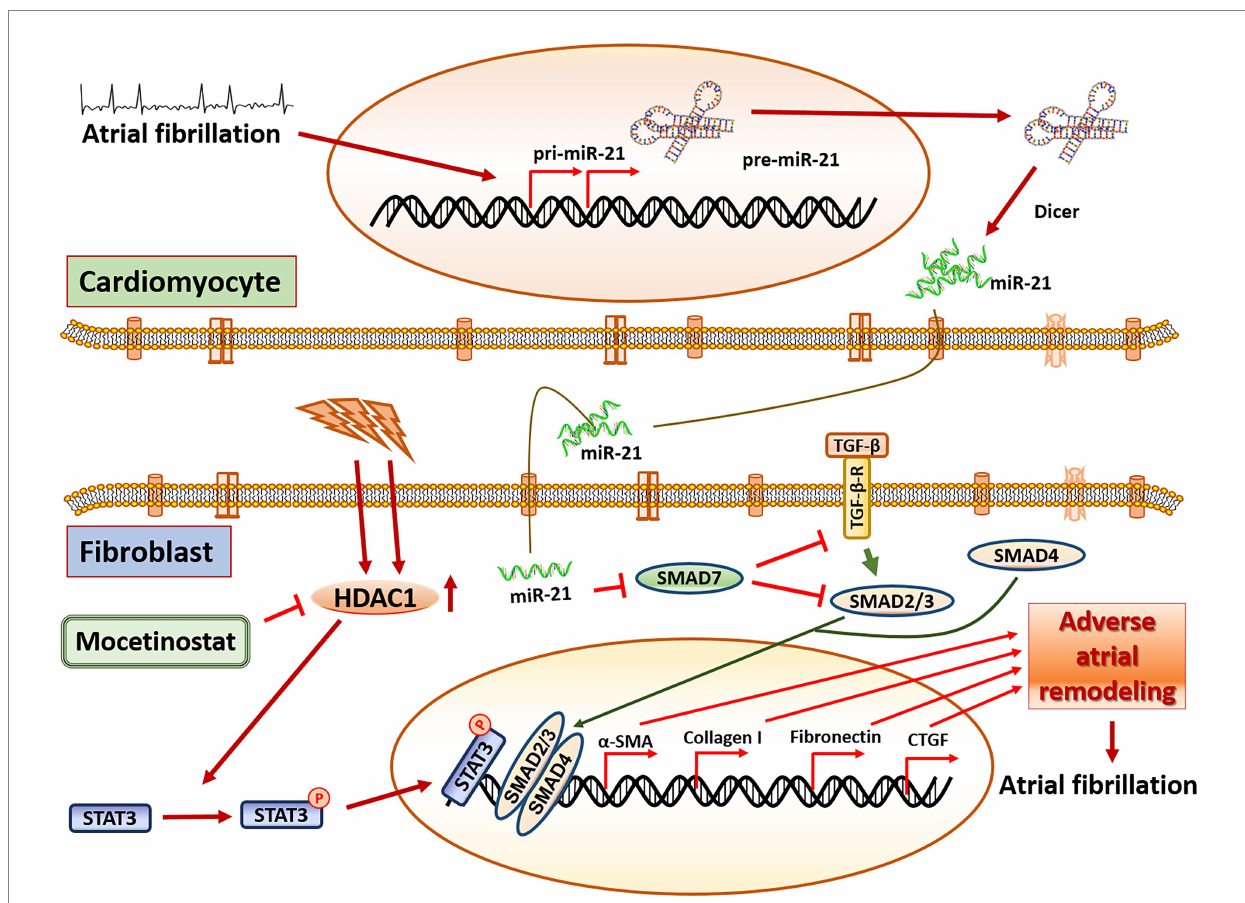
FIGURE 5 Central illustration. The proposed pathway in miR-21 mediated adverse atrial remodeling. miR-21 is released from cardiomyocytes under tachyarrhythmic conditions and triggers pro-fibrotic pathways in fibroblasts, mainly through the SMAD7/TGF-b pathway. Mocetinostat, an HDAC1 inhibitor, attenuates miR-21 dependent adverse atrial remodeling and collagen creation by antagonizing the STAT3-pathway. Tgf- β : transforming growth factor beta 1, Tgf- β -R: transforming growth factor beta receptor, HDAC1: Histone deacetylase 1, Smad7: SMAD family member 7, Smad2/3: SMAD family member 2/3, Smad4: SMAD family member 4, STAT3: signal transducer and activator of transcription 3, α -SMA: alpha smooth muscle actin, CTGF: connective tissue growth